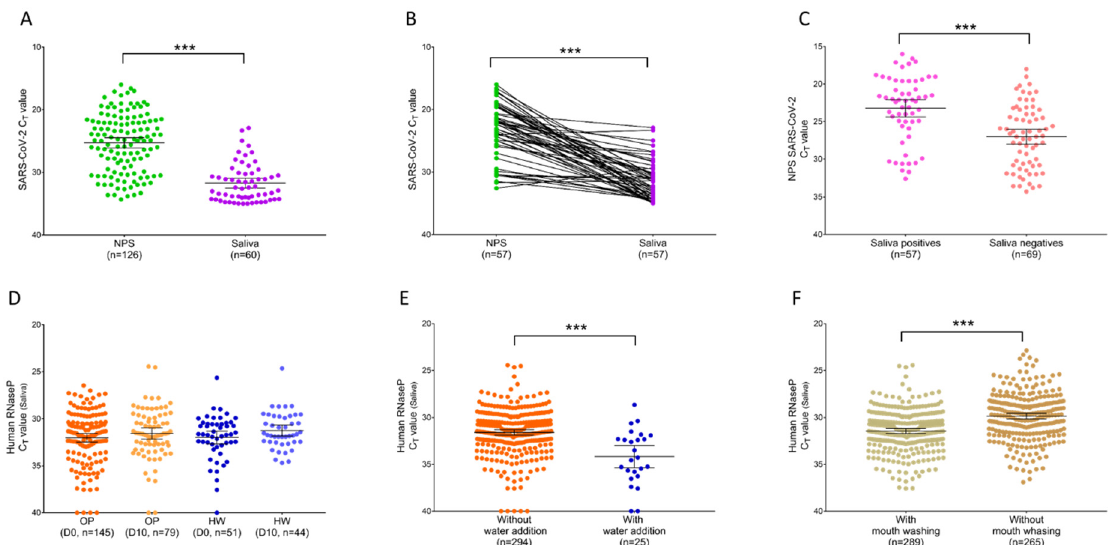
Figure 1. Comparison of Ct values from NPSs and saliva samples. ( A ) Ct values from all SARS-CoV-2 positive NPSs ( n = 126) and saliva ( n = 60) samples were compared using a Mann-Whitney U test (*** p < 0.0001). ( B ) Paired SARS-CoV-2 positive samples ( n = 57), represented by the connecting lines, were compared by a Wilcoxon test (*** p < 0.0001). ( C ) SARS-CoV-2 Ct values from positive NPS samples found positives ( n = 57) or negatives ( n = 69) in saliva specimens were compared by a Mann-Whitney U test (*** p < 0.0001). ( D ) Comparison of human RNase P (HRNP) Ct values from saliva samples between outpatients (OP) collected at D0 ( n = 145), D10 ( n = 79) and healthcare workers (HW) collected at D0 ( n = 51), D10 ( n = 44) ( p > 0.05, Kruskal-Wallis test). ( E ) Comparison of human RNase P Ct values between saliva samples with ( n = 25) and without ( n = 294) water addition (*** p < 0.0001, Mann-Whitney U test). ( F ) Comparison of human RNase P Ct values between saliva samples collected with Salivettes without water addition, with ( n = 265, present work) and without ( n = 289, previous study [15]) mouth washing before sampling (*** p < 0.0001, Mann-Whitney U test). Uniquely significant paired comparisons were indicated. Bars represent the median and 95% CI.